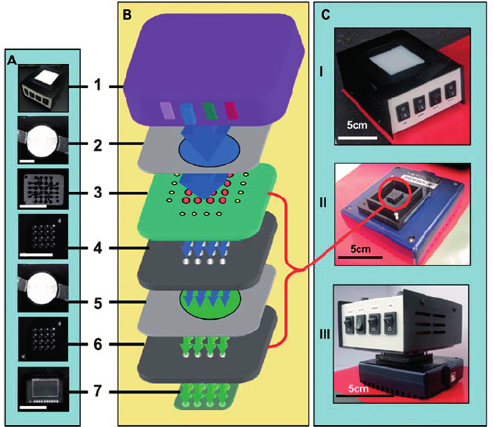
Figure 15. ( A ) Photograph of elements of on-chip fluorescent detection platform using Söller collimators. ( B ) Schematic image of elements of device. The image 1 is the main element which contained multi-wavelength LEDs. Image 2 and 5 are filters (blue and green emission filter respectively), and image 4 and 6 are light collimators. The microfluidic channels were shown in image 3 and 7 is the CCD camera. ( C ) Photograph of assembled device (Reproduced with permission from